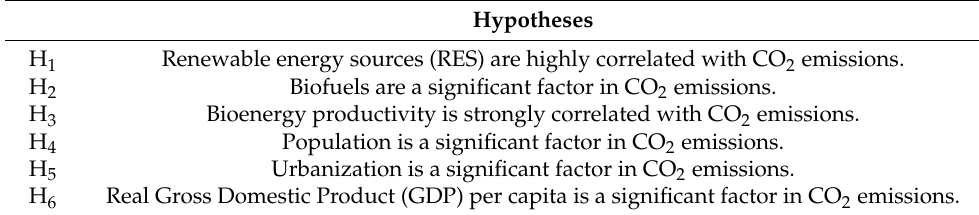
Table 1. Statistical Hypotheses of the Regression